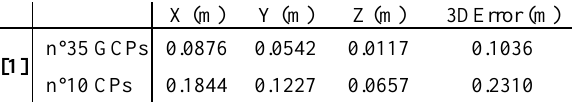
Table 2. The RMSE results on GCPs and CPs for the traditional processing images block, without direct geo-referencing data.